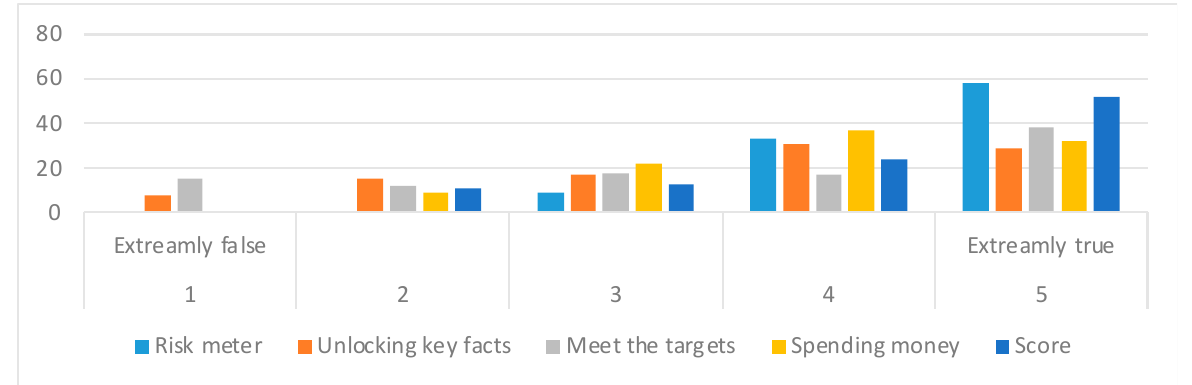
Figure 9. Extrinsic motivations of STOP Disasters gamified application.